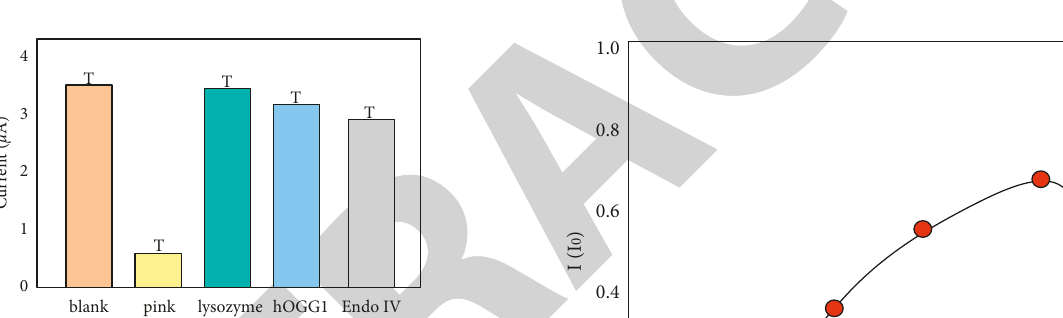
Figure 9: Selectivity of the analytical method.